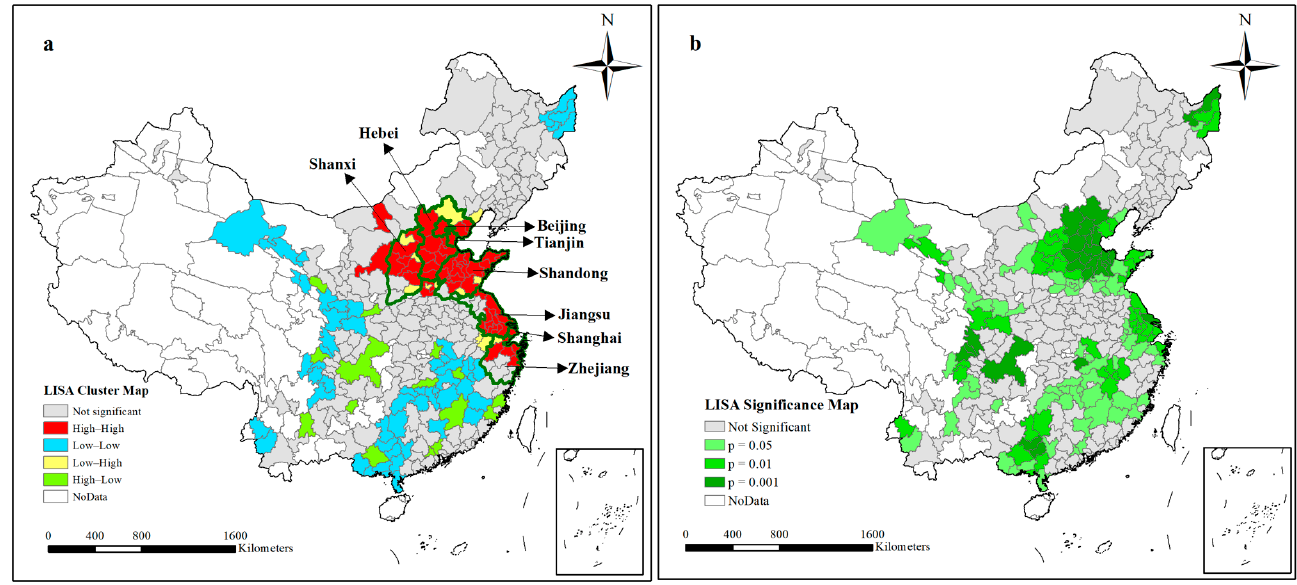
Figure 3. The local spatial autocorrelation of carbon emissions in 282 cities in 2017: ( a ) the local indicators of spatial autocorrelation (LISA) cluster map; ( b ) LISA significance map. Note: In the LISA significance map, p = 0.001 indicates significance at the 1‰ level, p = 0.01 indicates significance at the 1% level, p = 0.05 indicates significance at the 5% level. If the significance level is below 5%, the city passes the significance test.